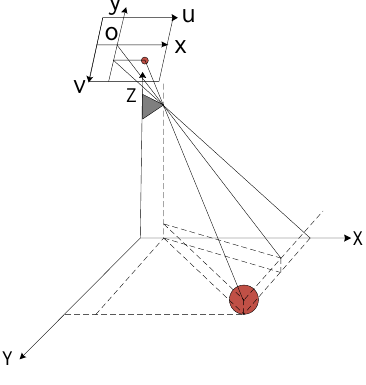
Figure 1. Monocular vision location model.